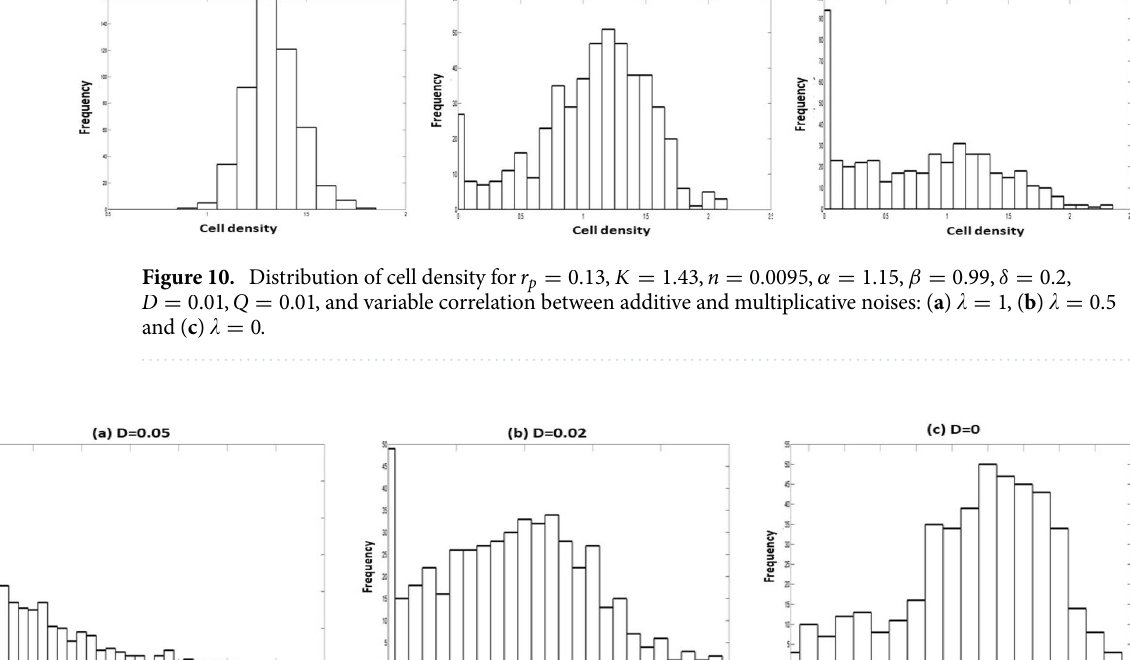
0.13 , K 1.43 , n 0.0095 , α 1.15 , β 0.2 , 0.99 , δ = = = = = = 0.05 , ( b ) D 0.02 and ( c ) D 0 . = = =